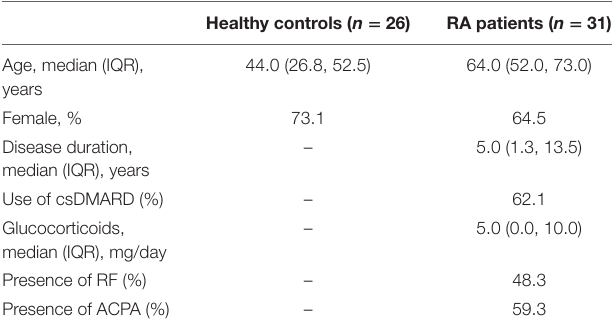
TaBle 1 | Characteristics of the subjects at